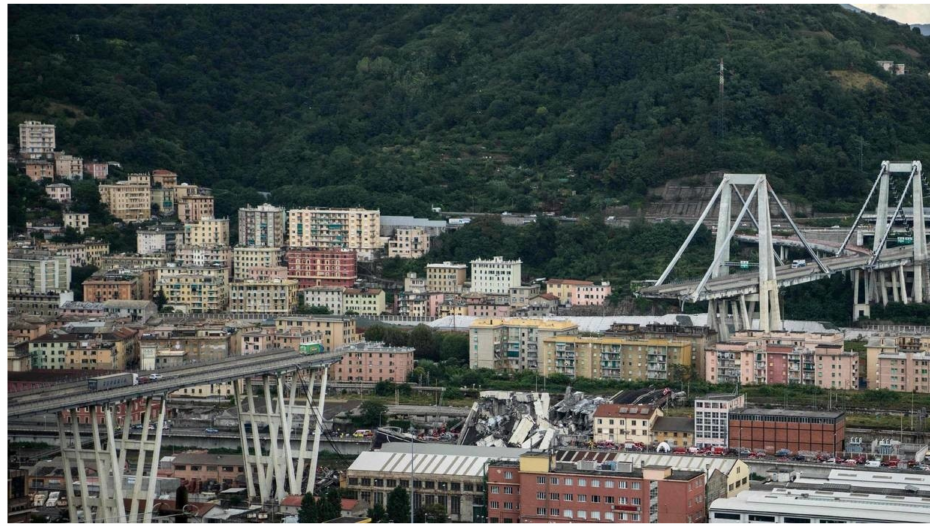
Figure 1. View of the collapsed part of the Polcever viaduct in Genoa, August 2018. (AP Photo, Antonio Calanni,